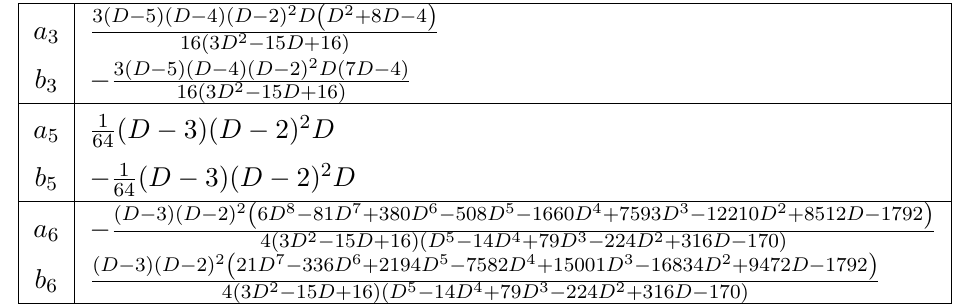
Table 6. Coefficients a , b of the shear viscosity contribution from quintic ETQT terms. Each entry corresponds to the solution with the same indices in (A.5). Entries with vanishing coefficients are